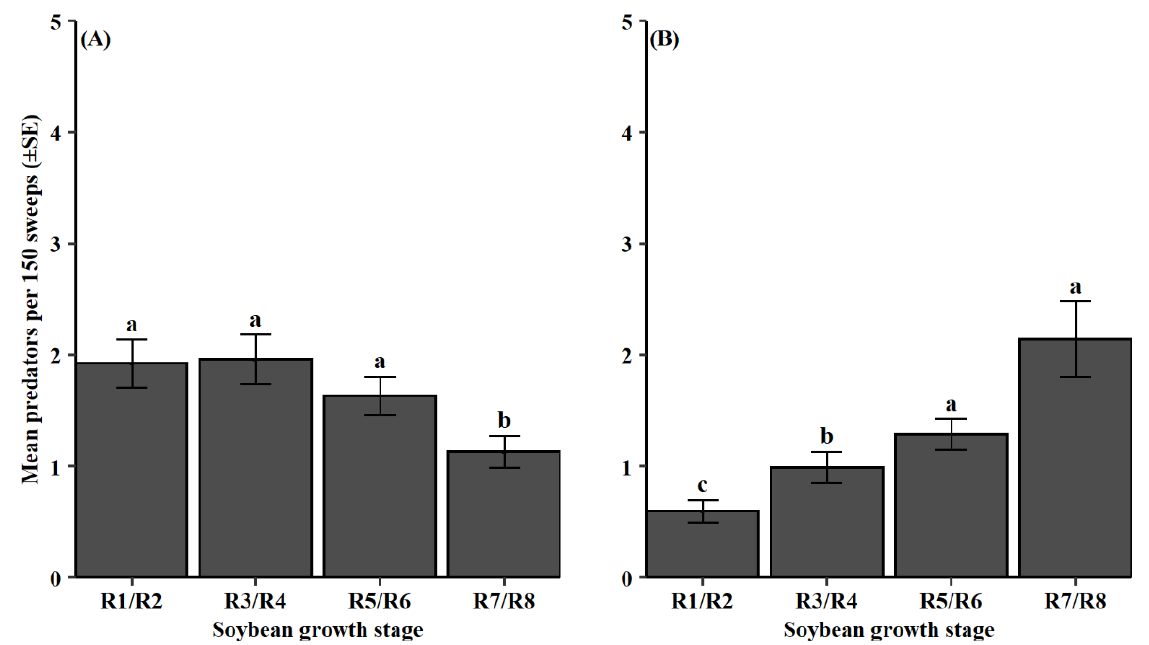
Figure 5. Mean predator count per 150 sweeps ( ± SE) for observed soybean growth stages during ( A ) 2012–2014 and ( B ) 2015–2018. Same letter denotes no significant difference between means ( p > 0.05).